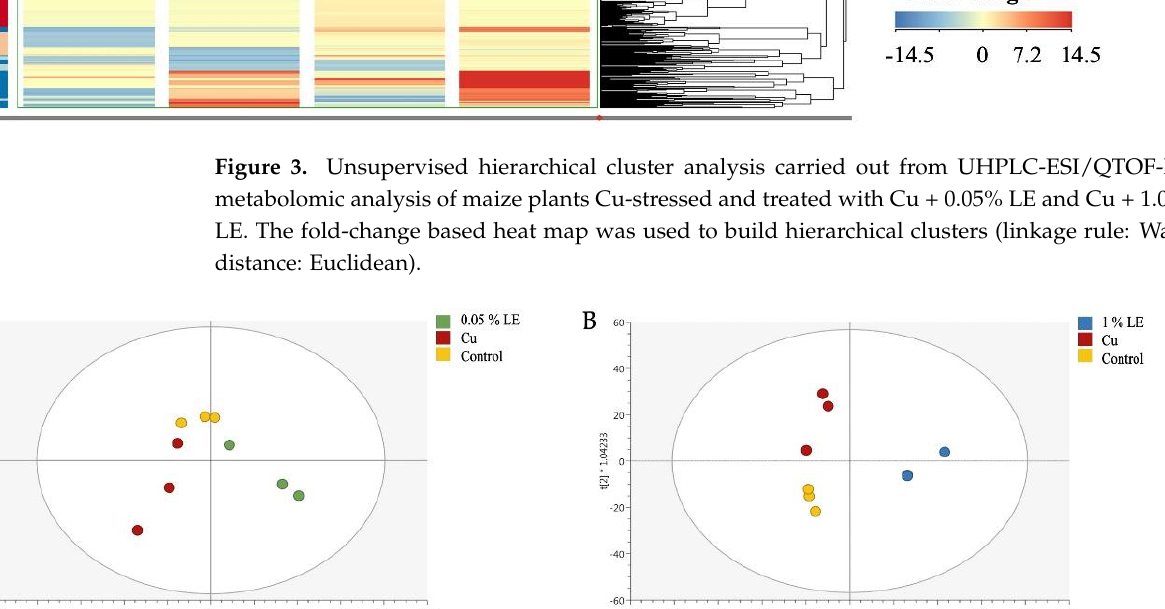
Figure 3. Unsupervised hierarchical cluster analysis carried out from UHPLC-ESI/QTOF-MS metab- olomic analysis of maize plants Cu-stressed and treated with Cu + 0.05% LE and Cu + 1.00% LE. The fold-change based heat map was used to build hierarchical clusters (linkage rule: Ward; distance: Euclidean).